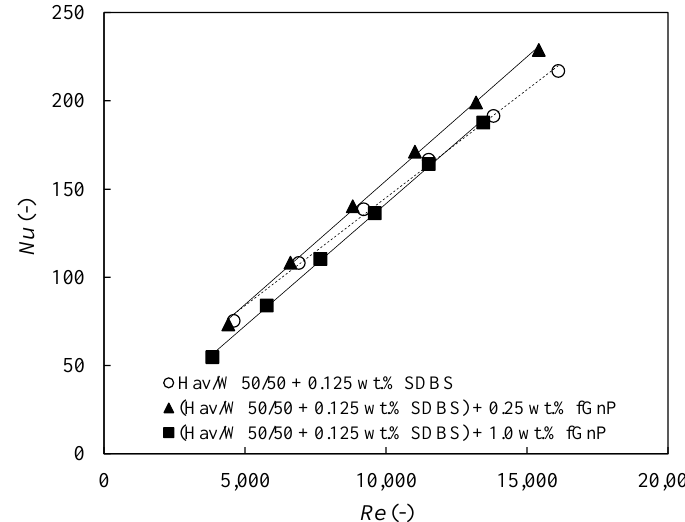
Figure 8. Nusselt number, Nu , as function of Reynolds number, Re , for base fluid and 0.25 and 1.0 wt % nanofluids at T nf = 318.15 K.